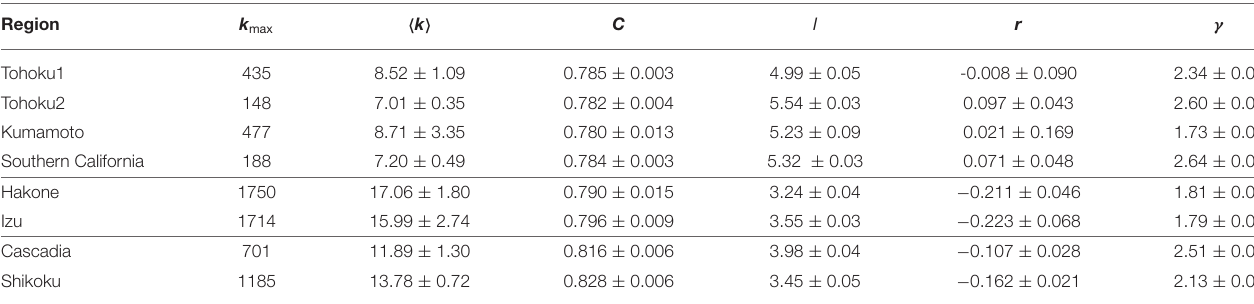
k , clustering coefficient C , shortest path length l , and Pearson correlation coefficient r for the h i 2 12 =